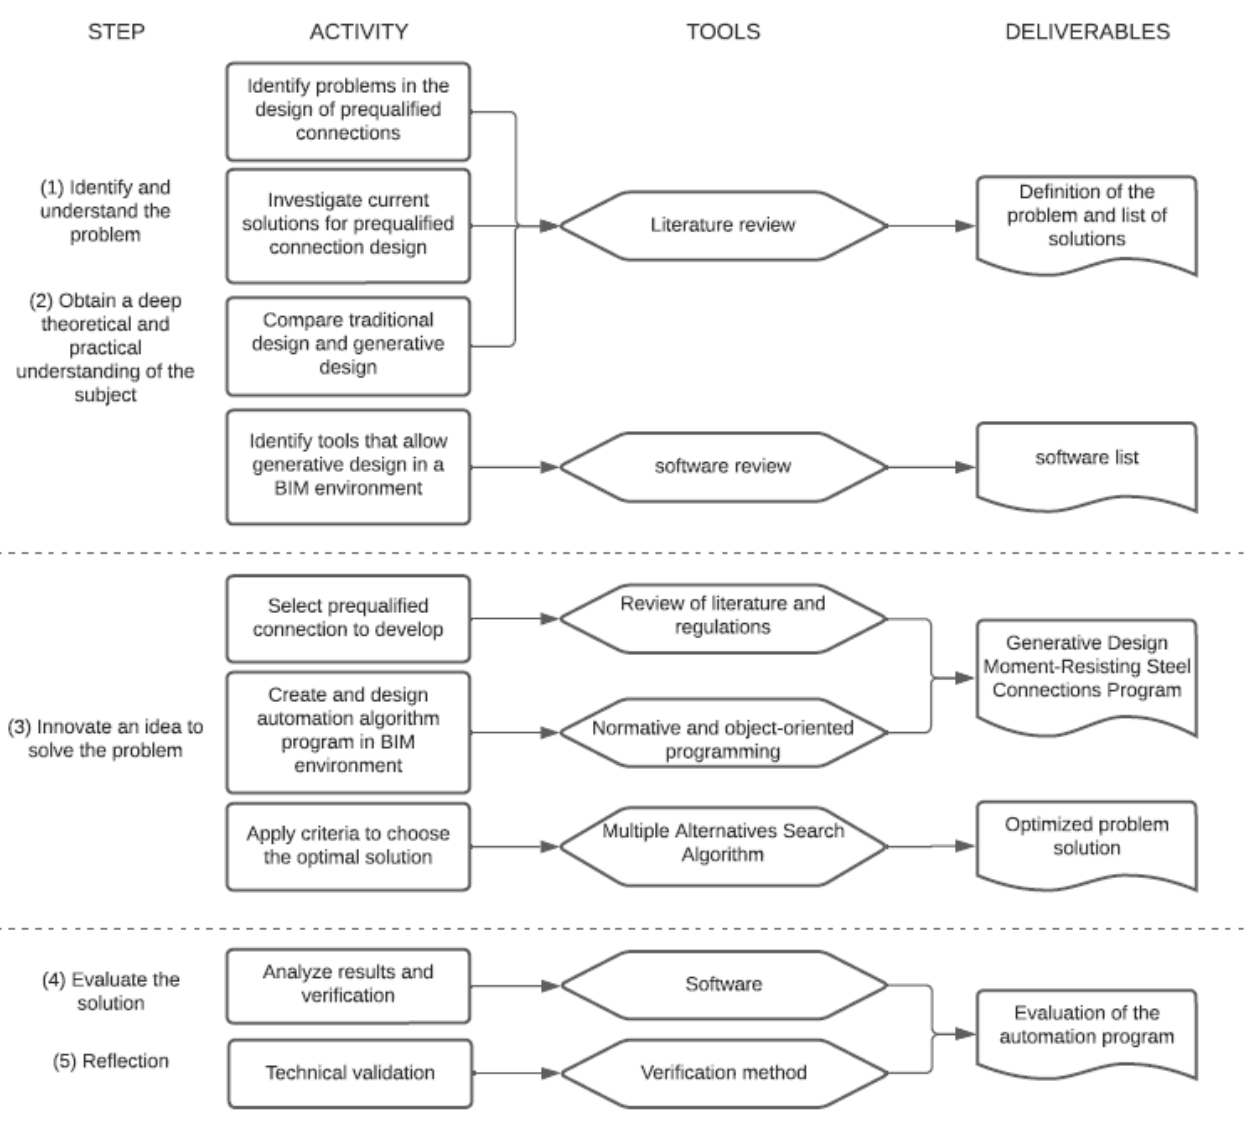
Figure 3. Research methodology. Source: the authors.